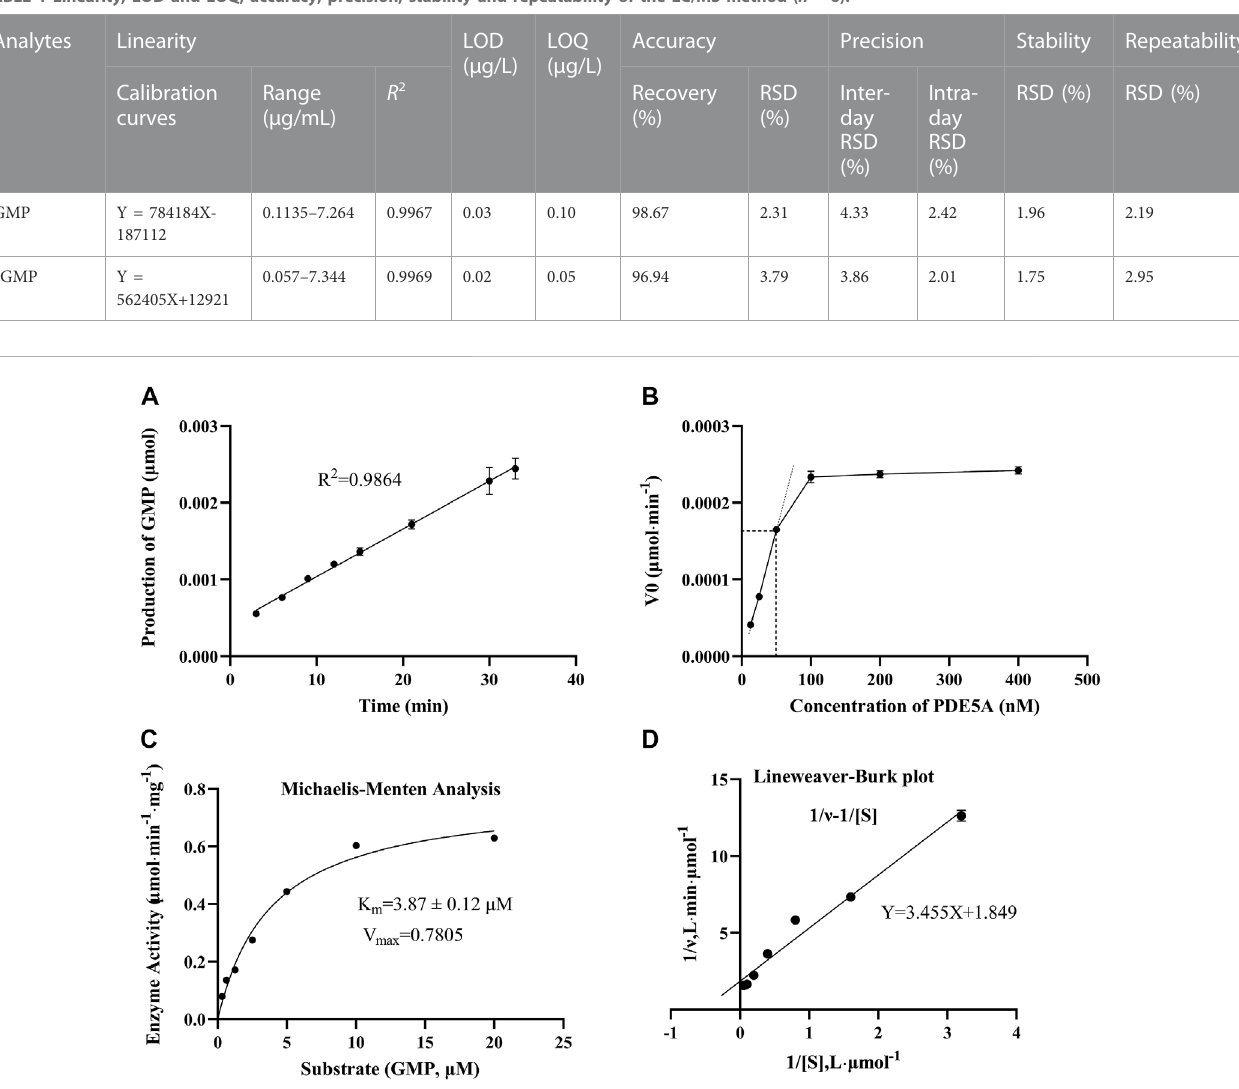
FIGURE 3 The results of the enzymatic activity assay of PDE5A. (A) Enzyme reaction progress curve. The linear portion of the reaction progress curve was fi tted according to the throughput of GMP. (B) Enzyme concentration curve. The change in the initial reaction velocity (V 0 ) was determined at different enzyme